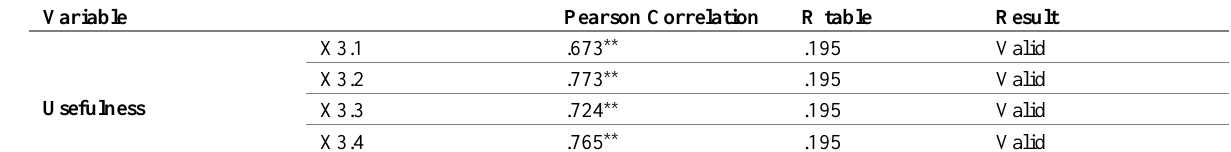
Table 4: Usefulness Validity Test Results